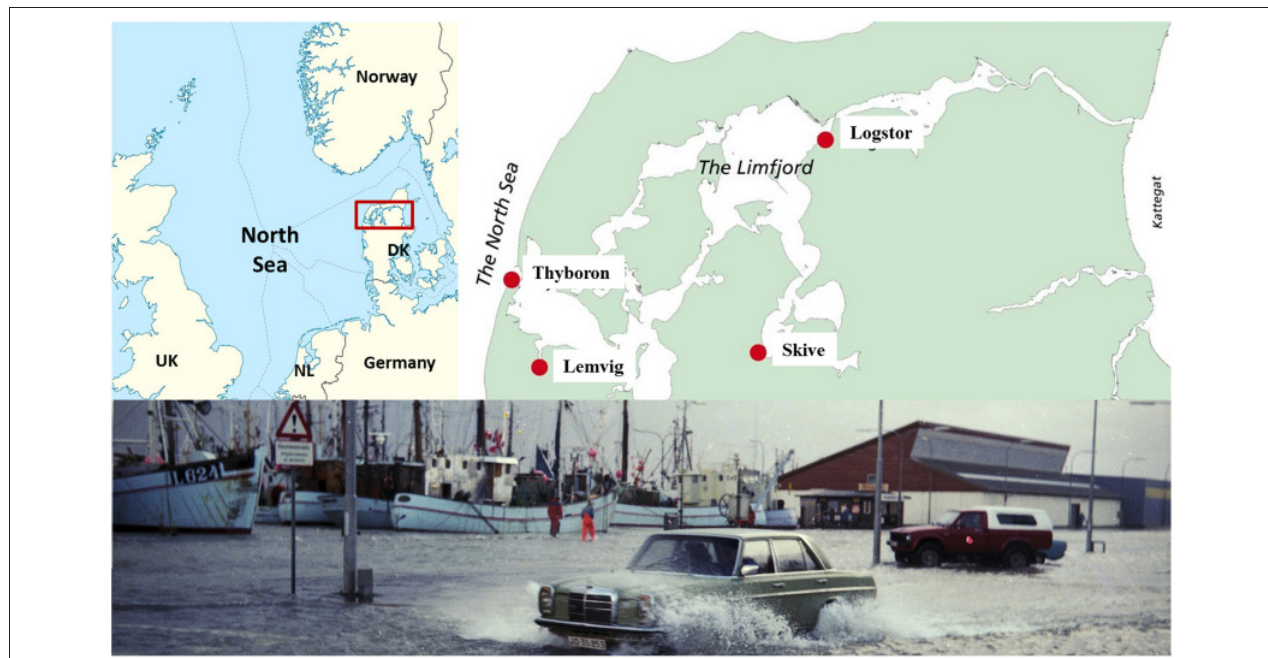
FIGURE 1 | Study area. The Danish town of Thyboron is located on the eastern North Sea coast and hosts a large harbor by the Thyboron Channel that connects the North Sea and the Limfjord. The town has experienced several minor floods like in 1981 (Photo: Thyboron-Harboore-Engbjerg Local